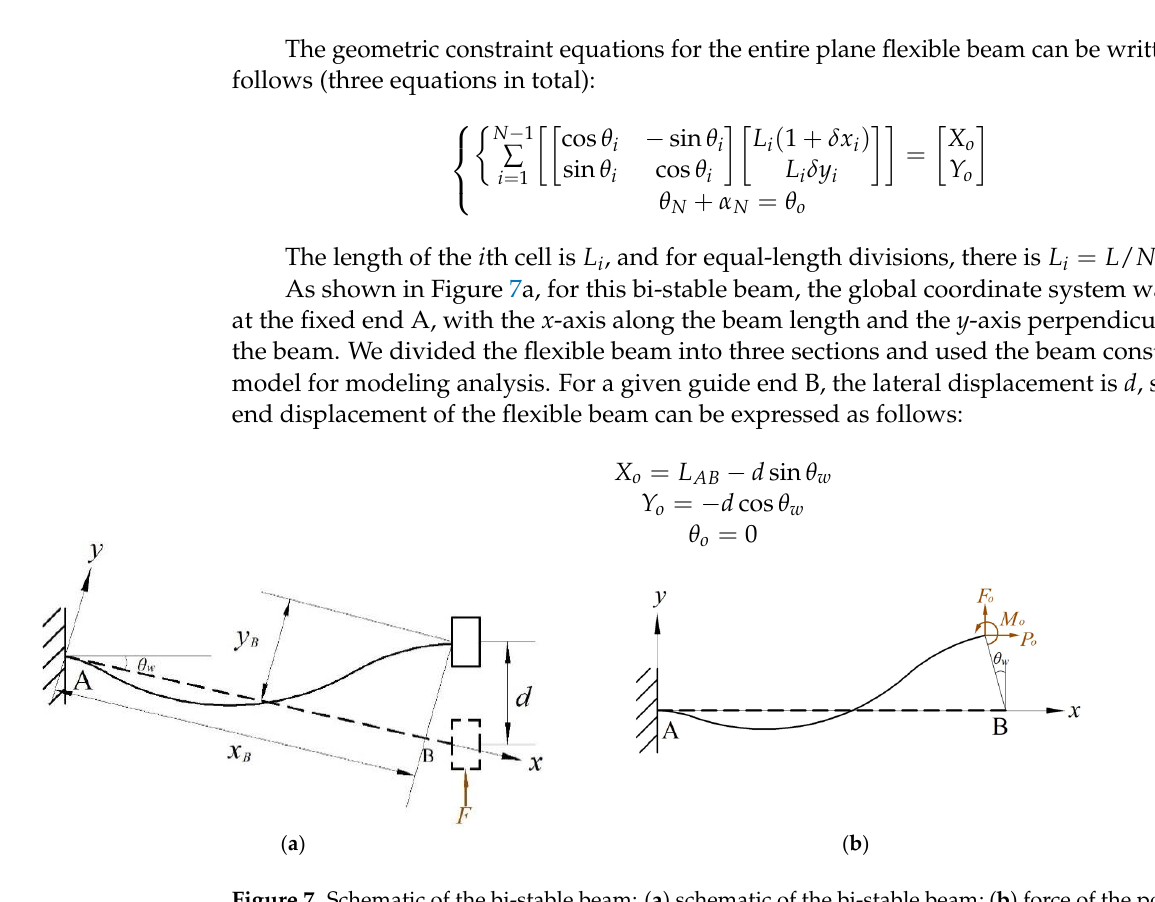
Figure 8. Analytical model results of the CFM.